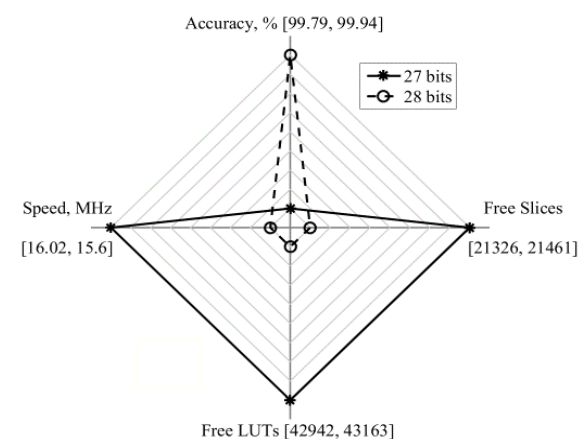
Fig. 9. Comparison of FPGA resources used and calculation accuracy when implementations of NPQ MP system with different number of bits for the fractional part of binary word result in the same number of 85 DSP cells